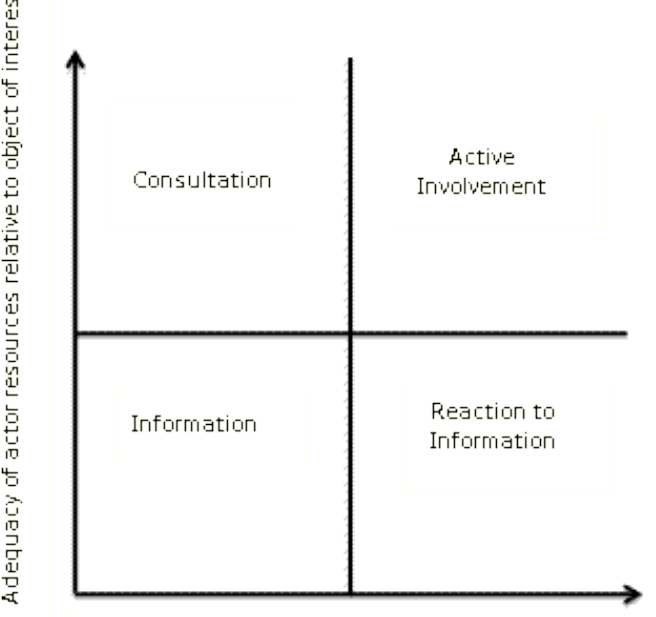
Fig. 4. Determining levels of involvement by matching stakeholder resources to levels of